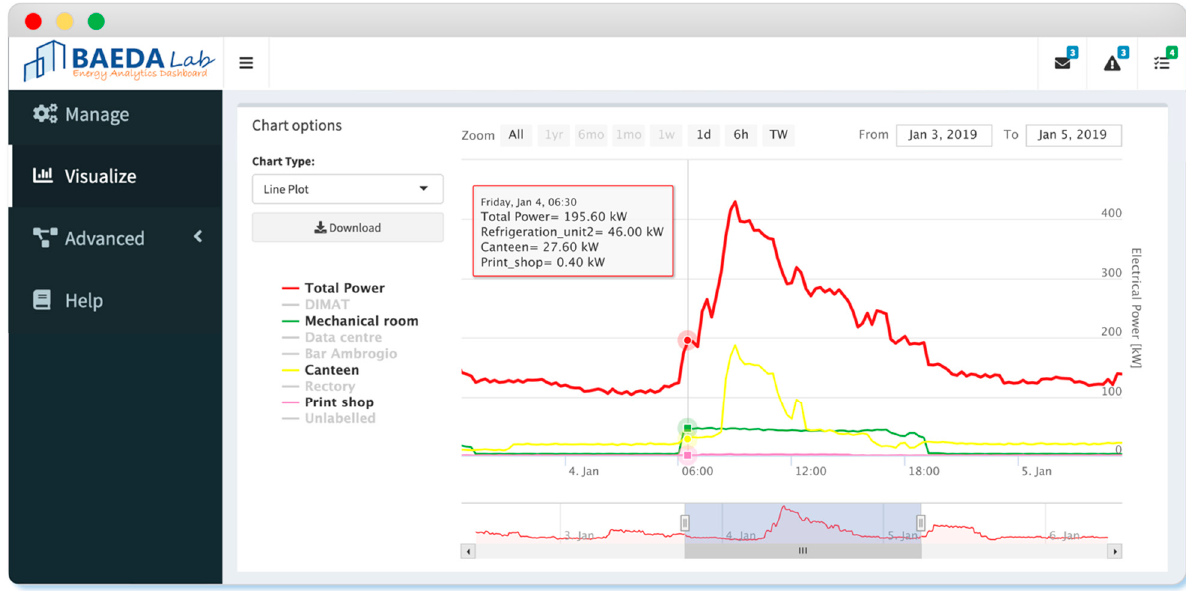
Figure 16. Energy data analytics dashboard developed by the building automation and energy data analytics (BAEDA) Lab, which implements the anomaly detection and diagnosis (ADD) procedure presented in this paper.